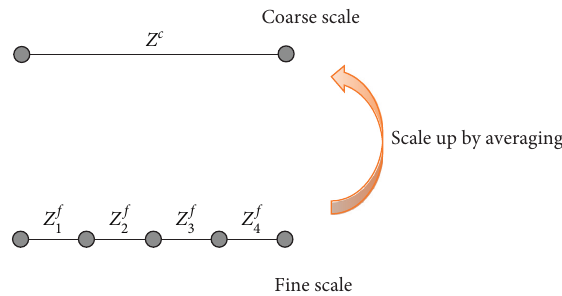
Figure 1: Illustration of the material properties at coarse and fine scales and the averaging